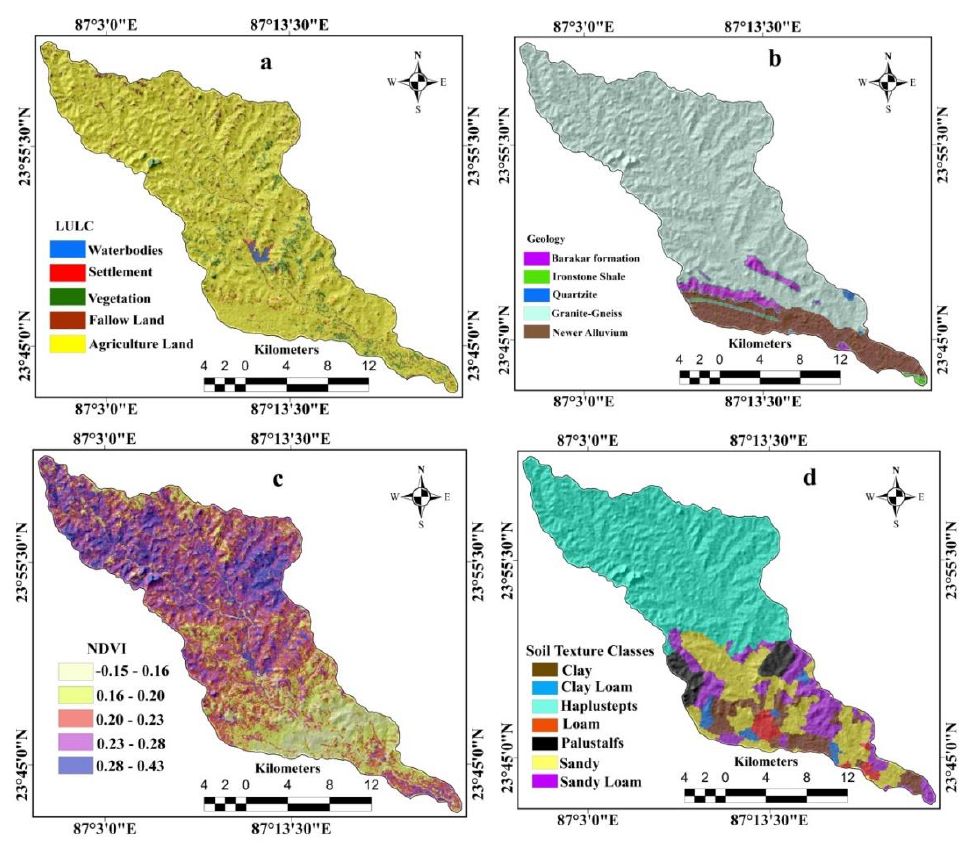
Figure 6. The environmental factors: ( a ) land use / land cover (LULC), ( b ) geology, ( c ) normalized difference vegetation index (NDVI), ( d ) soil type.